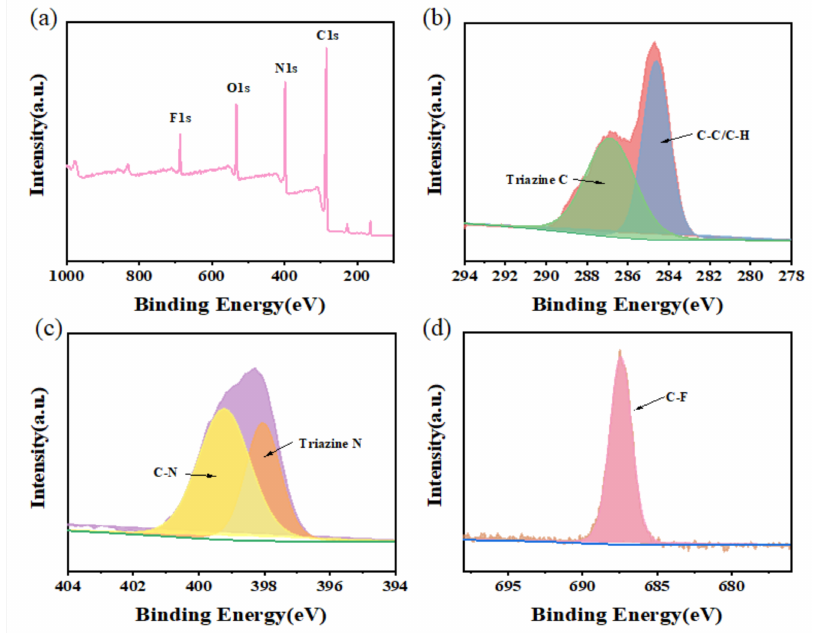
Figure 3. XPS spectra of POP-4F: ( a ) wide-scan survey spectra; high-resolution of ( b ) C 1s; ( c ) N 1s; ( d ) F 1s.